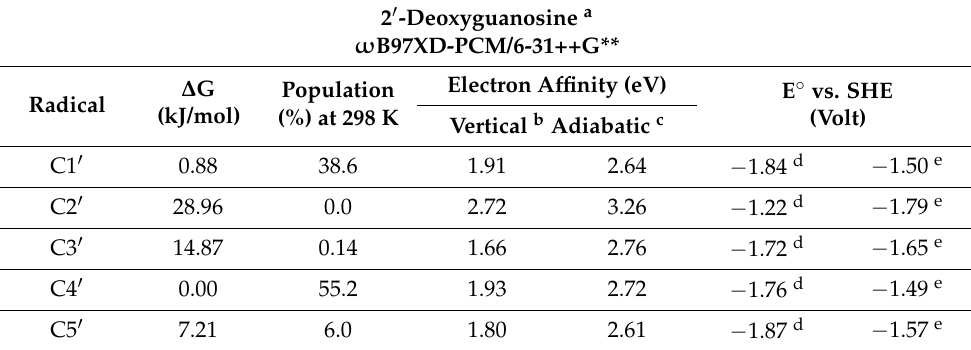
Table 1. The ω B97XD-PCM/6-31++G**-calculated relative free energies ( ∆ G), relative populations based on Boltzmann distribution, electron affinities, and one-electron reduction potential (E ◦ ) of sugar radicals of 2 (cid:48) -dG.